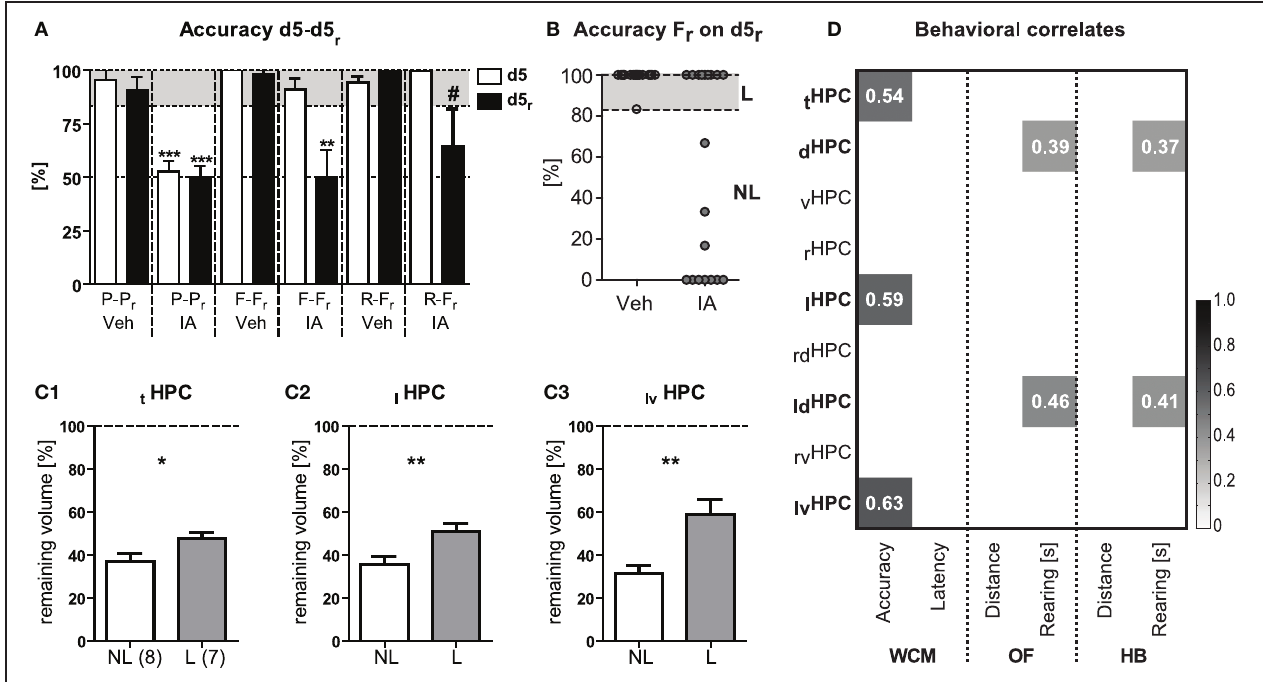
FIGURE 8 | Relearning performance and HPC shrinkage. HPC volume reduction following ibotenic acid treatment was related to distinct behavioral phenotypes. (A) Accuracy at d5 and d5 r is shown for all three batches of animals (cf. Figures 5 – 7 ). IA animals failed to learn the platform position under P-P r protocol [ t ( 11 ) ≥ 9 . 21, p < 0 . 001]. For F-F r protocol, IA mice accurately learned the task in the 1st but failed in the 2nd